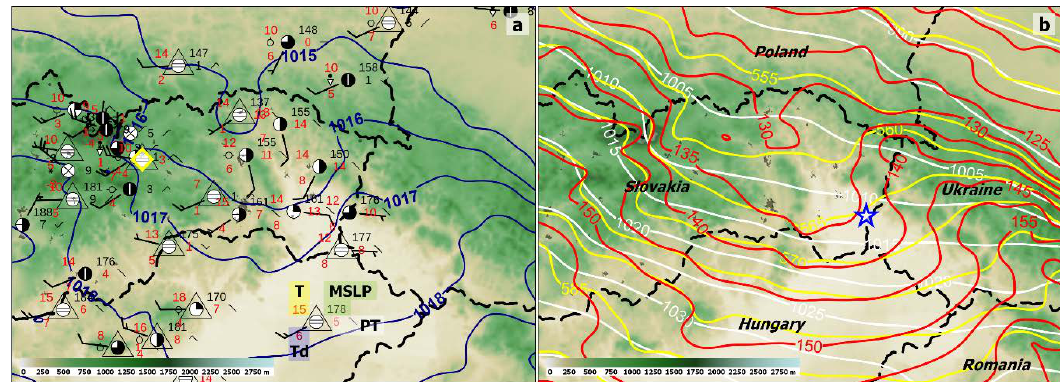
Figure 7. ( a ) Surface weather-station observations on 3 October 2018 12:00 UTC based on synoptic reports and analysis of mean sea-level pressure (hPa). Surface-station plots: T, air temperature (°C); Td, dew-point temperature (°C); MSLP, mean sea-level pressure (hPa); PT, 3-h pressure tendency (10 – 1 hPa); cloudiness represented by circles, and wind by wind barbs. Triangles, automatic weather stations; yellow rhombus, highlighted sounding location from Figure 9. ( b ) NWP OPM analysis of geopotential heights on 3 October 2018 12:00 UTC at 1000 (red), 950 (yellow), and 900 hPa (white) (gpm). Country names shown in italics; tornado location highlighted by blue star.